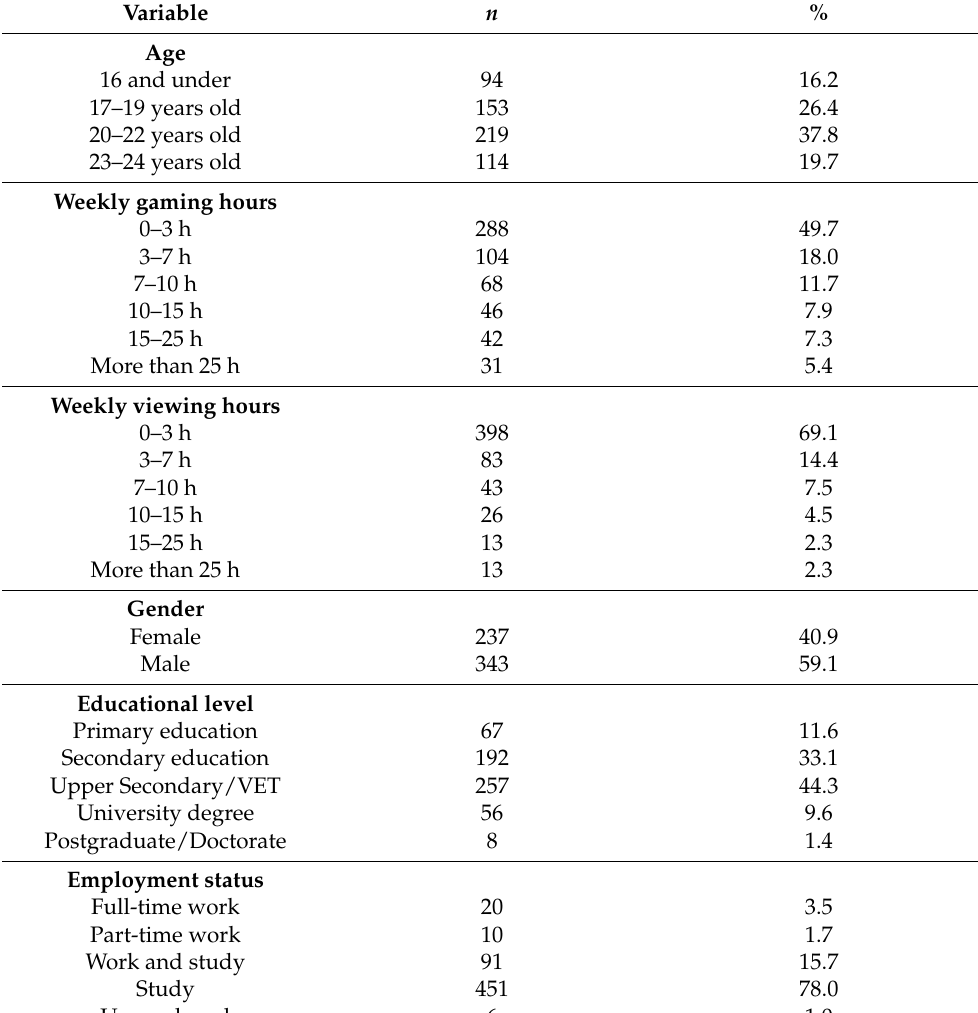
Table 1. Sociodemographic